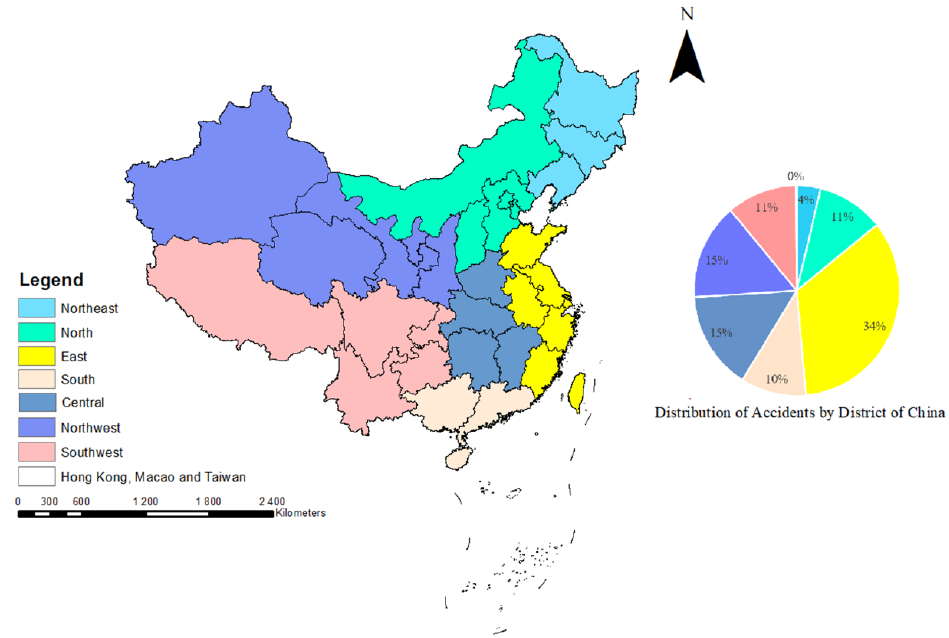
Figure 4. Division of different regions of China and distribution of accidents by district.